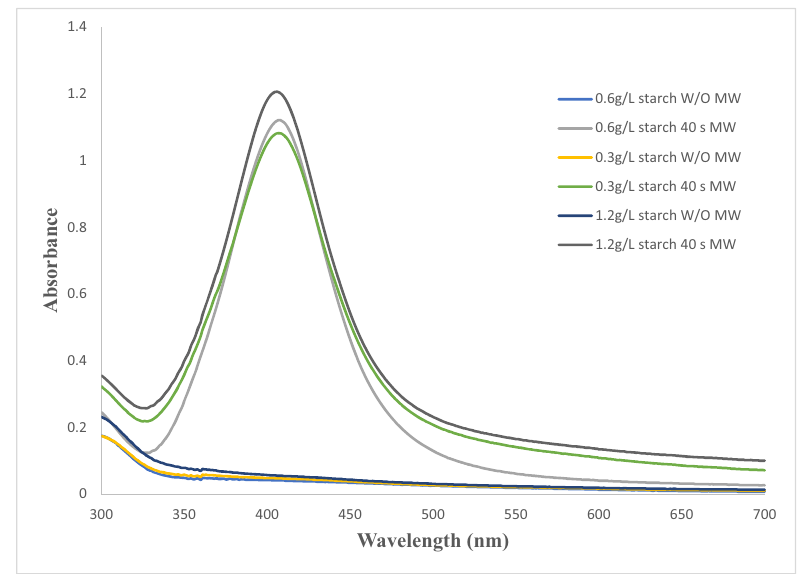
Figure 3: UV – Vis spectra of AgNPs synthesized using 5 g · L − 1 of AgNO 3 at di ff erent starch concentration and with ( W ) or without ( W/O ) microwave ( MW )